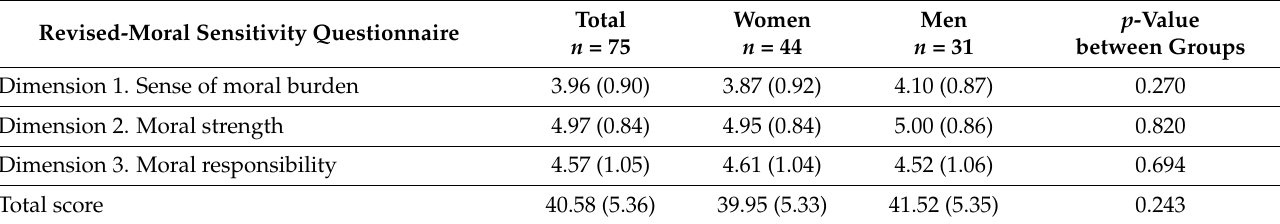
Table 3. Results of the Revised-Moral Sensitivity